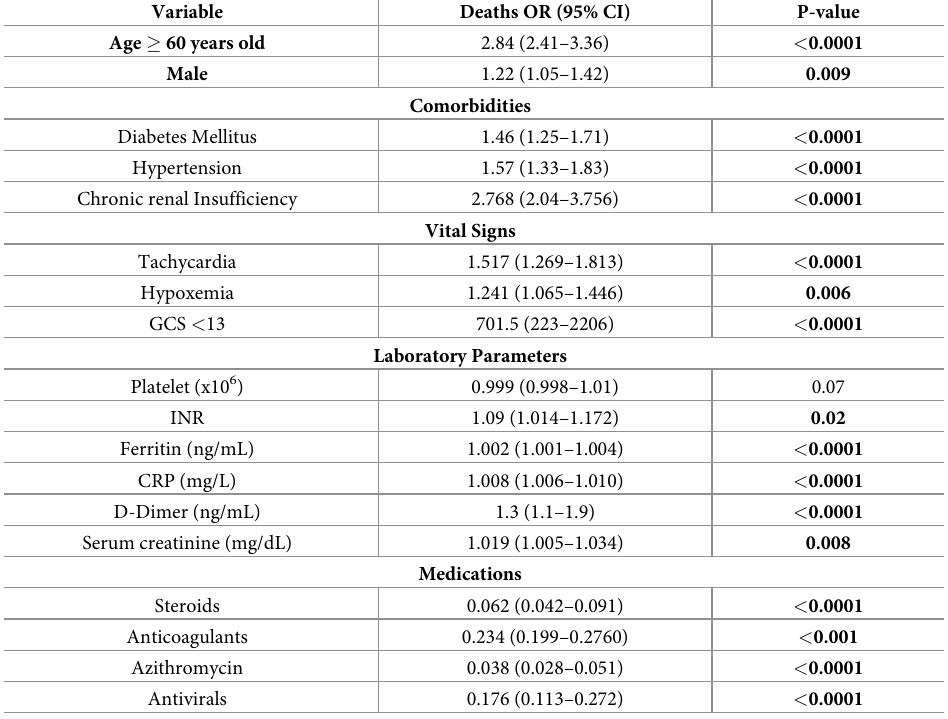
Table 3. Univariate risk predictors of COVID-19 mortality.